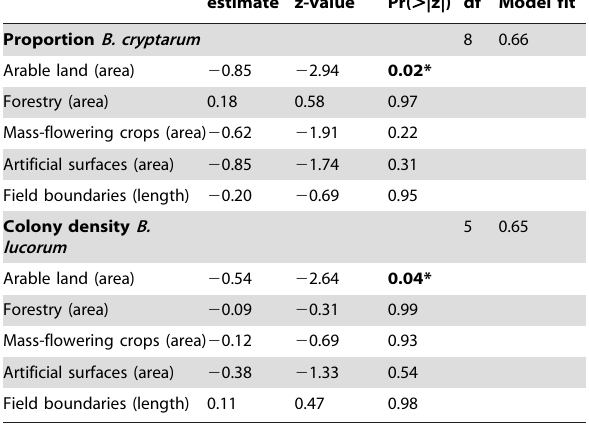
Figure 4. Negative relationships between amount of arable land in a 700 m radius and a) proportions of B.cryptarum and b) colony densities of B.lucorum . Points show normalised measured values, and lines show model